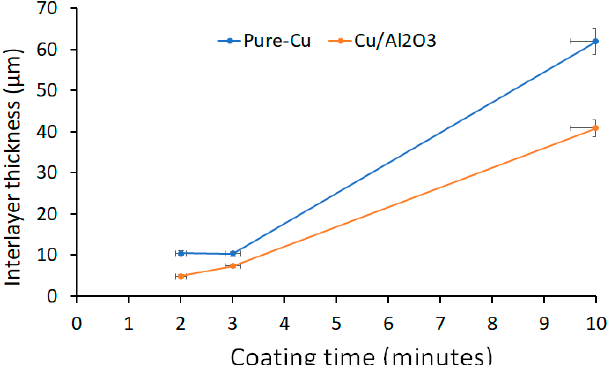
Figure 1. The relationship between the coating time and the thickness of the deposited coatings